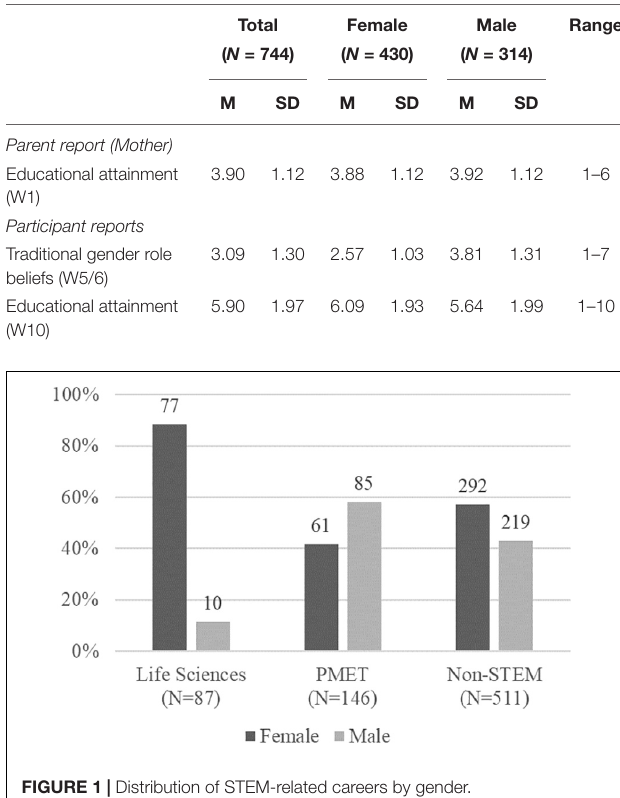
TABLE 1 | Descriptive statistics for relevant study variables.